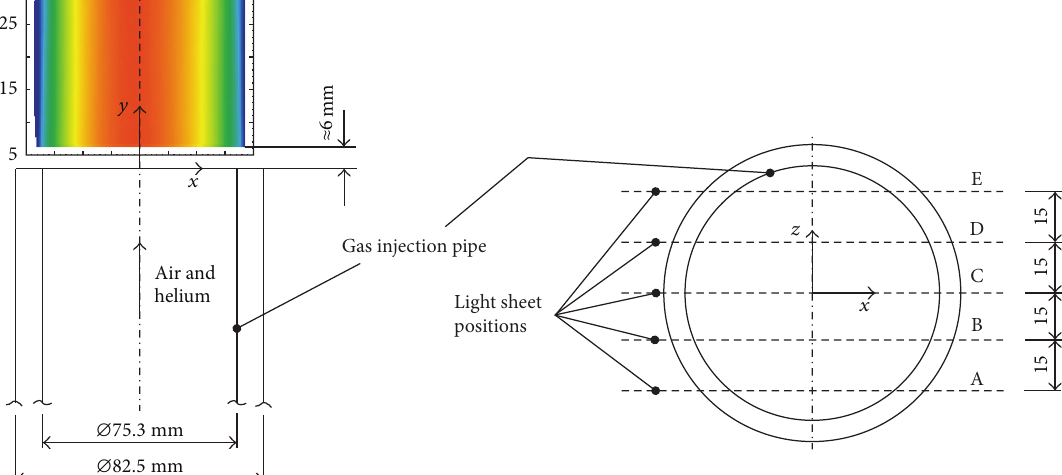
Figure 4: Relative positions of the FOVs of the PIV velocity measurements at the exit of the injection line; note the local coordinate system used for the measurement planes A–E which differs from the one given in Figure 1.